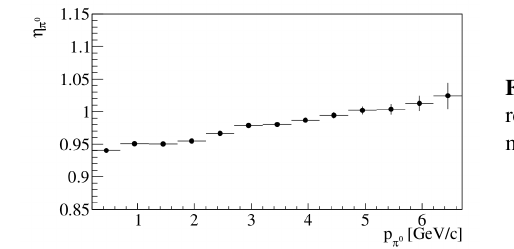
Figure 2. Correction weights for the π 0 reconstruction e ffi ciency as a function of the π 0 momentum p π 0